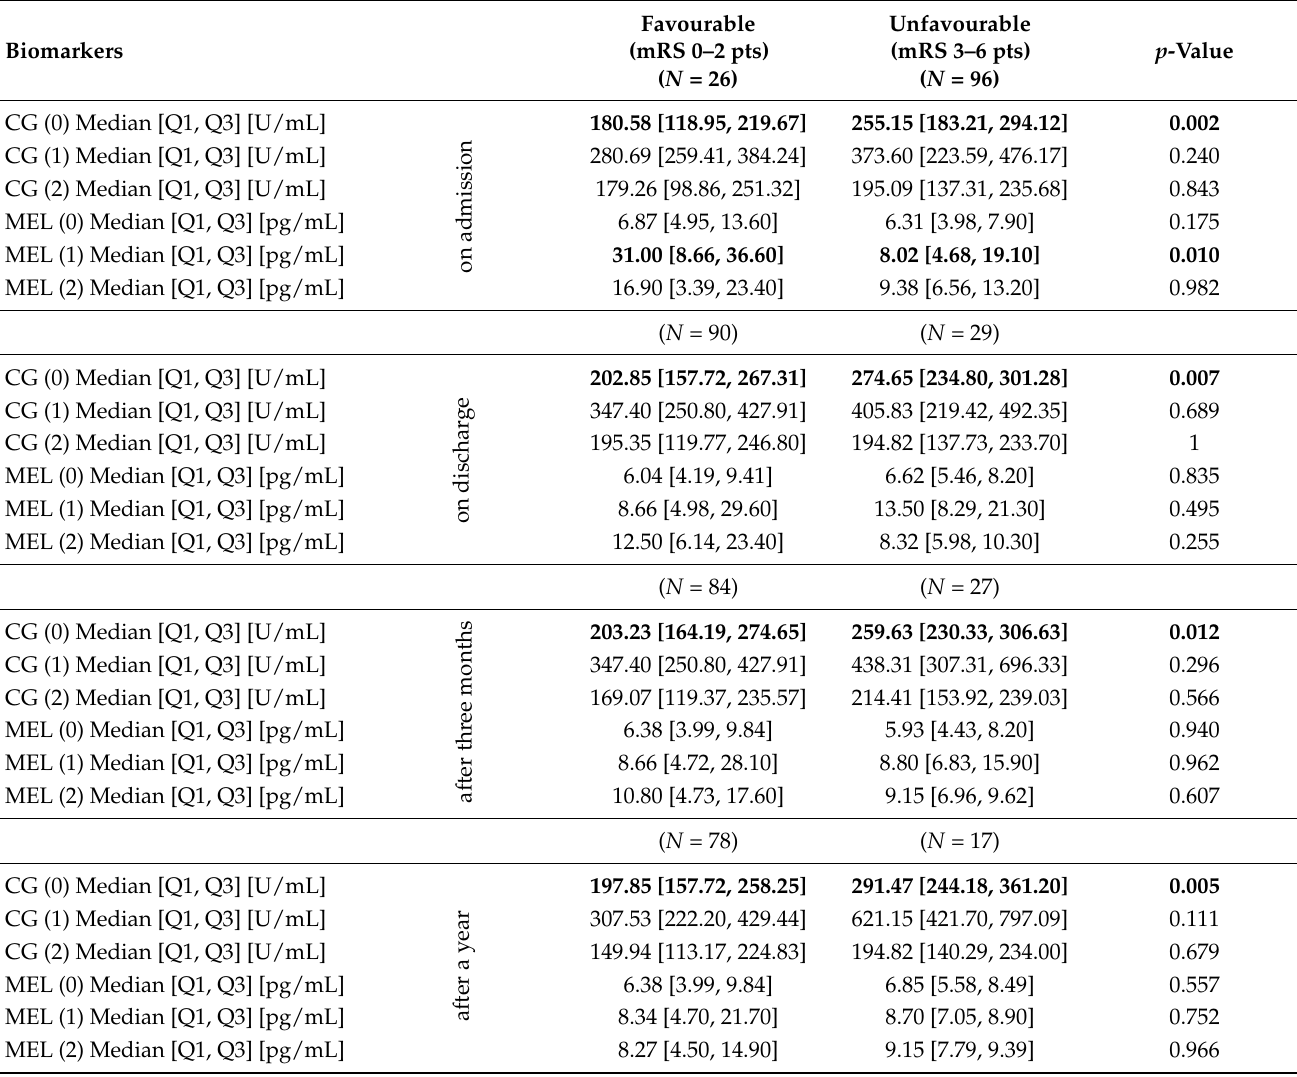
Table 2. MEL and GC levels before and after thrombolysis, considering the mRS scale.